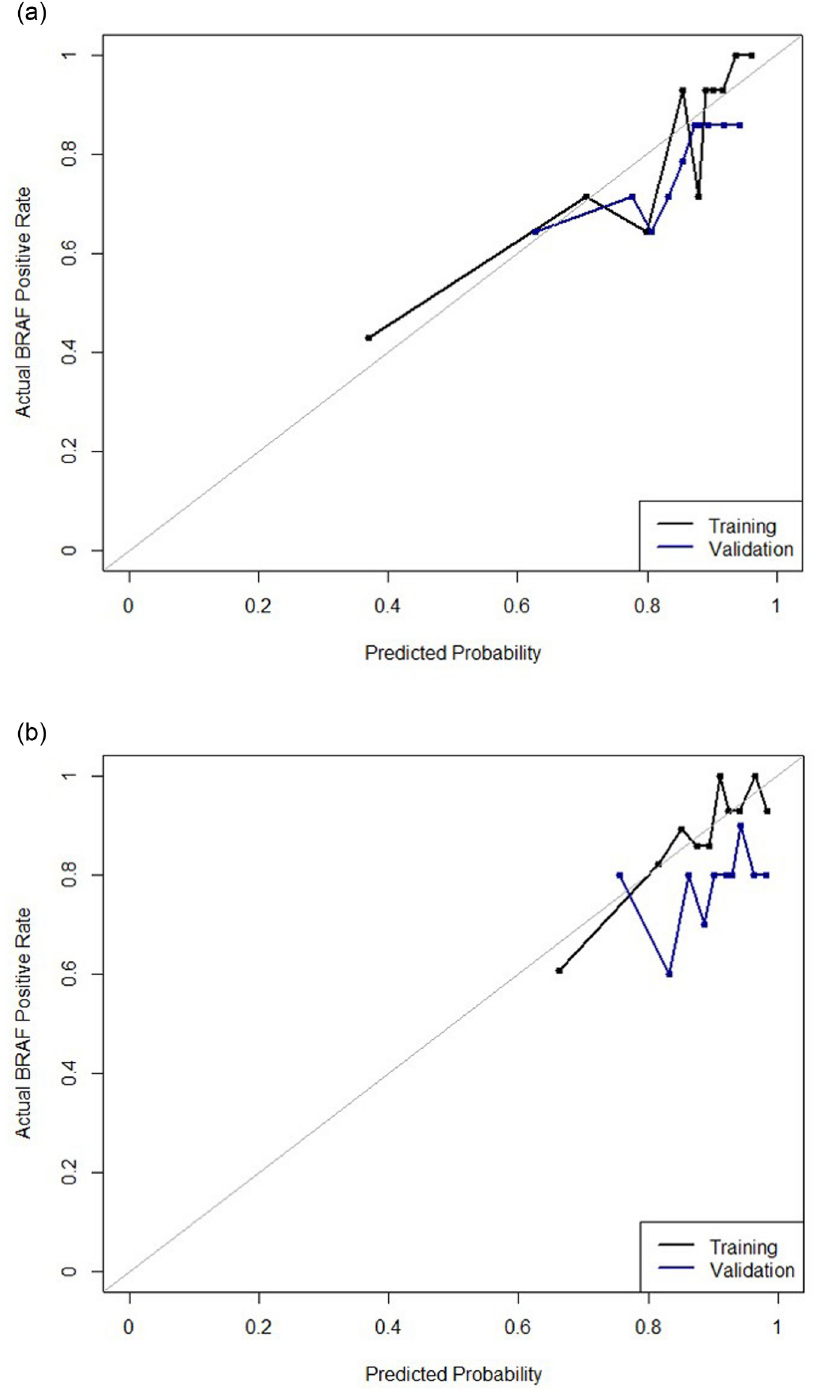
Fig 3. Calibration plots of the grouped prediction models for the presence of BRAF V600E mutation. For each plot, the y-axis represents the actual probability of BRAF V600E mutation, and the x-axis represents the predicted risk for BRAF V600E mutation. (A) Calibration plot for the total thyroid cancers and (B) conventional PTCs measuring < 20-mm included in this study.